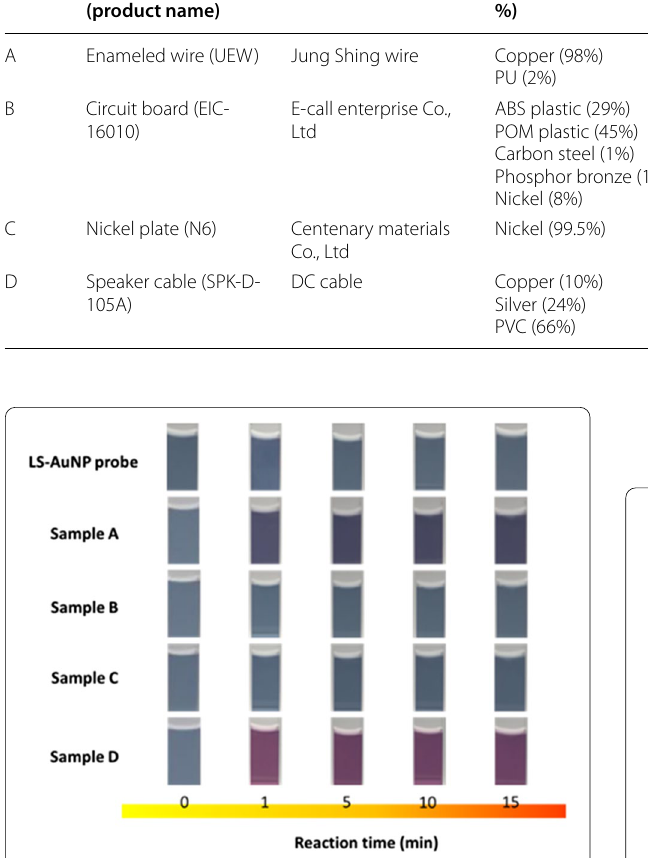
Fig. 4 Visual colorimetric table of four different samples with respect to reaction time